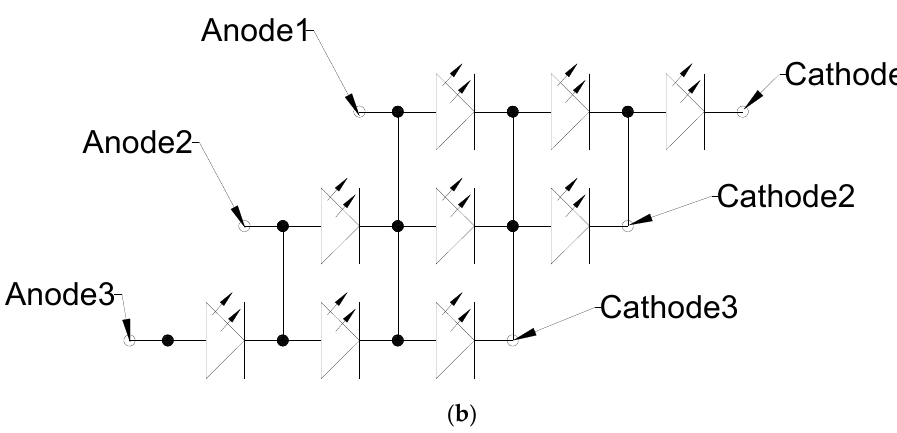
Figure 4. Our novel WOLED layout design and hyper driving method. ( a ) The layout scheme of nine sub-emitting WOLED panel; ( b ) The hyper driving topology of the entire panel.